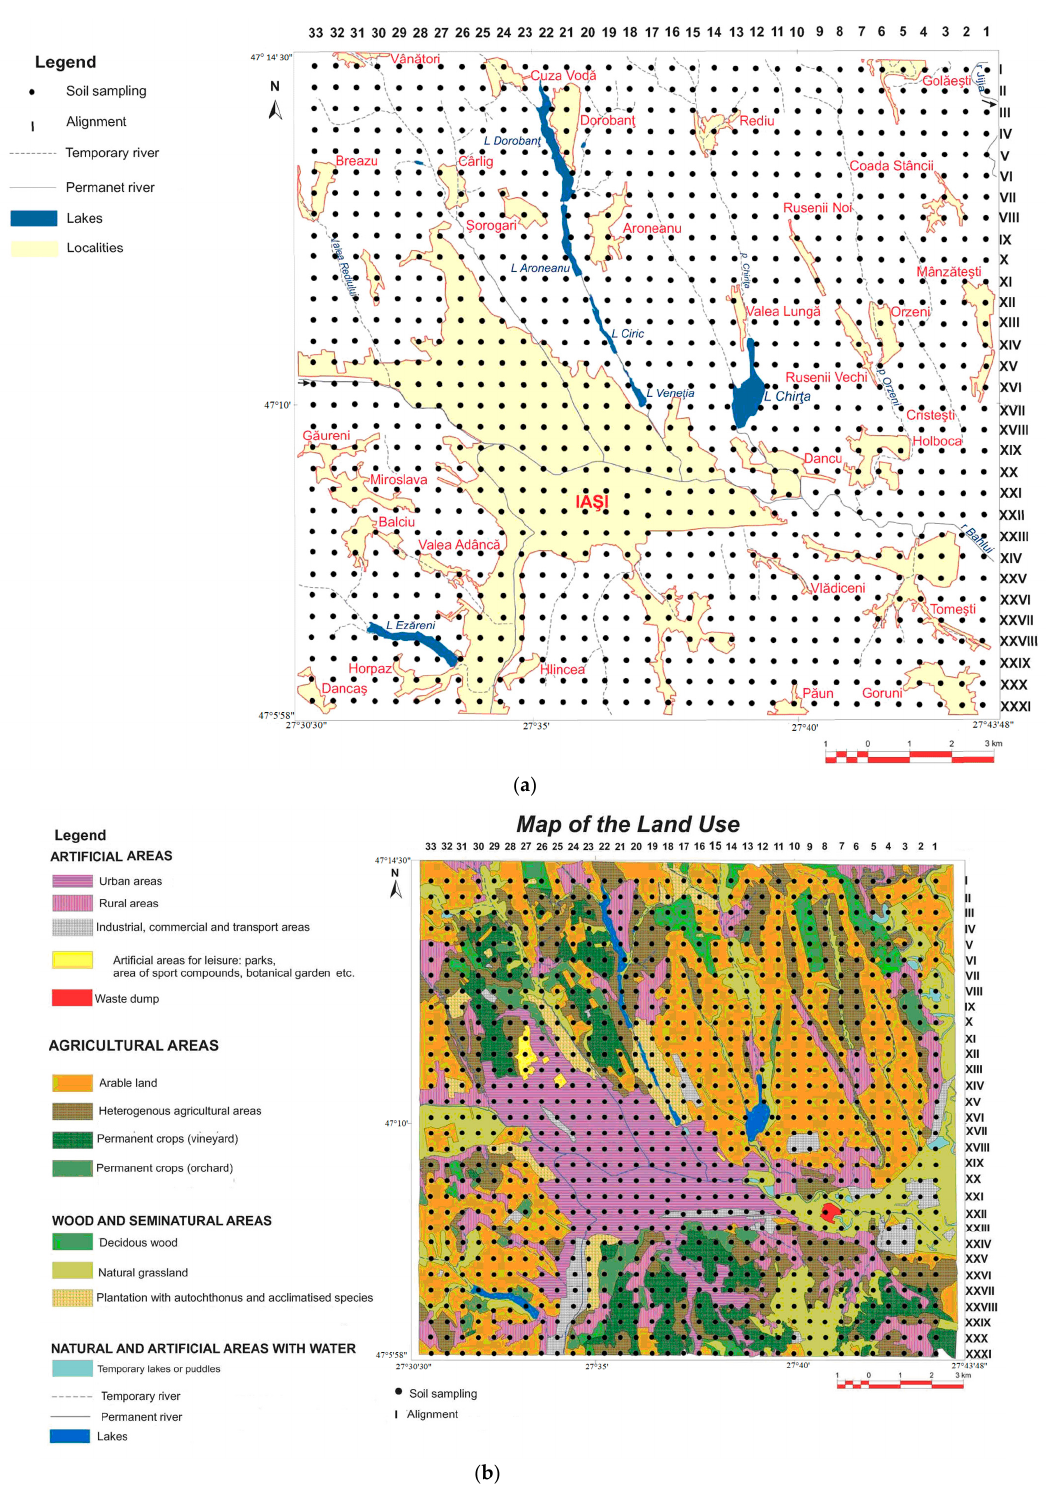
Figure 1. ( a ) Sample collection grid from the study area (16 km 2 ) including the built-up area of Iasi and its surroundings (1030 soil samples were taken at a depth of 0–25 cm from a network of 500 m); ( b ) land